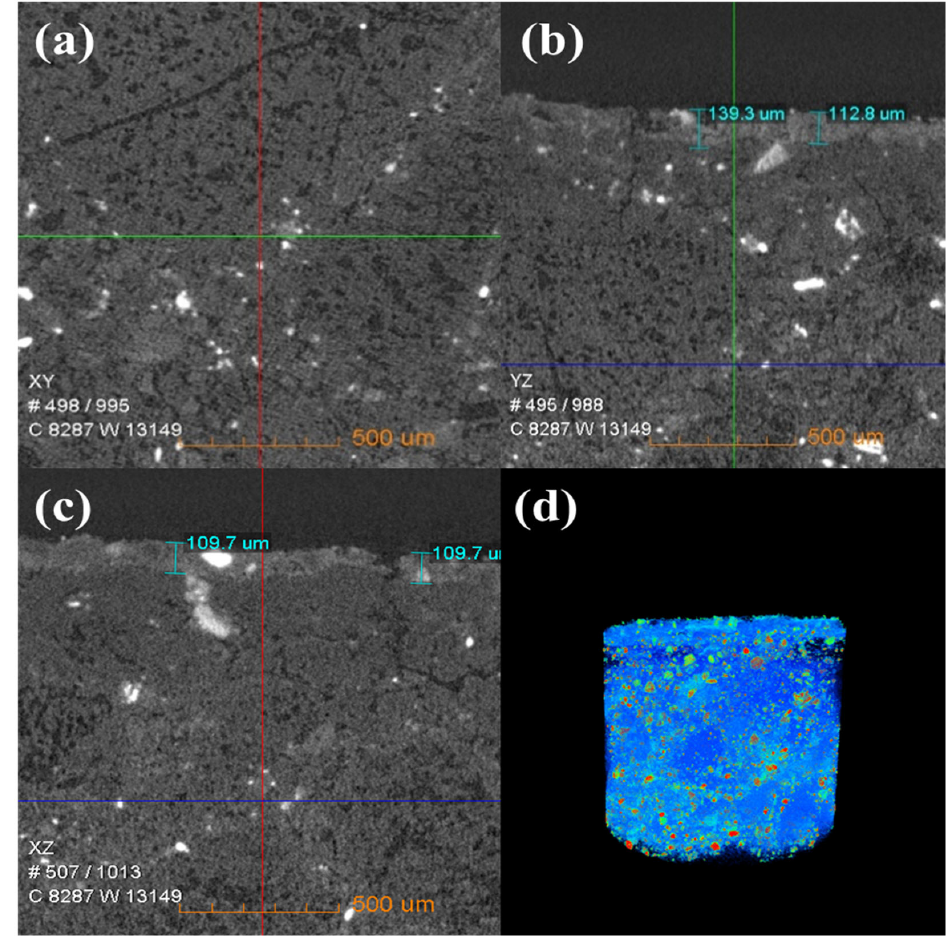
Figure 7. X-ray CT of a waste saggar sample. ( a ), ( b ), and ( c ) Internal X-ray CT figures of a waste saggar sample scanned from the XY, YZ, and XZ directions, respectively. ( d ) Three-dimensional image in which bright and dark colors represent high and low density, respectively.